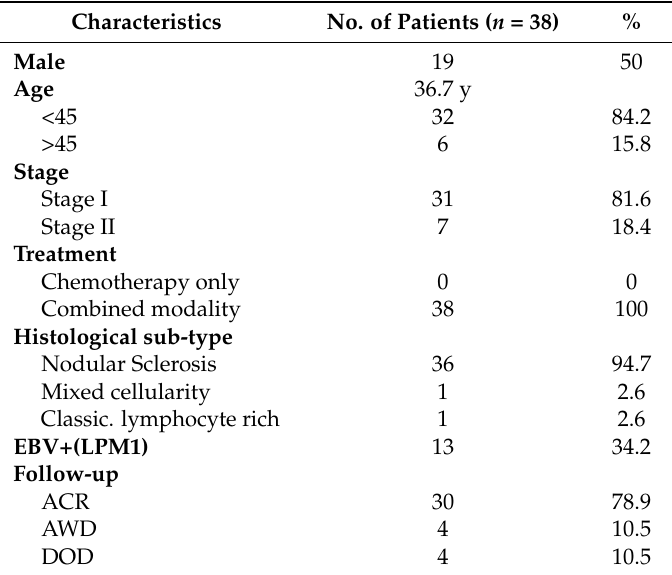
Table 1. HL Patient’s characteristics.